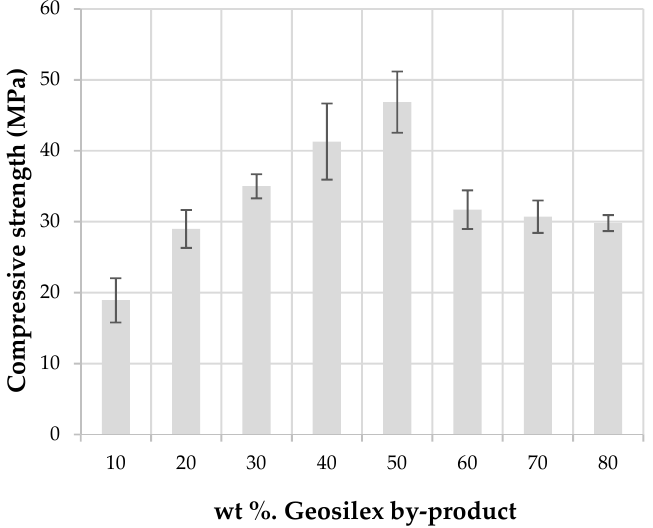
Figure 10. Compressive strength of the xWBA-yG calcium silicate units as function of G by-product content.